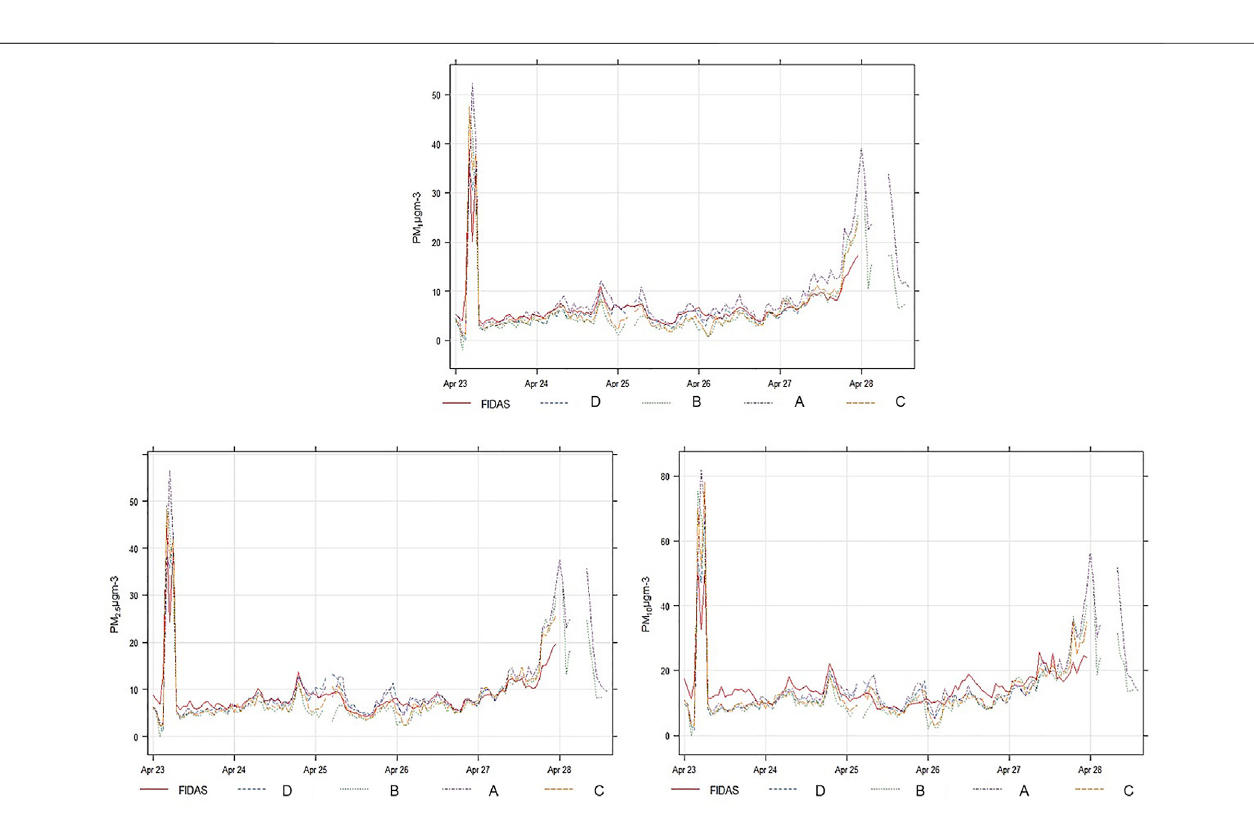
Frontiers in Environmental Science |